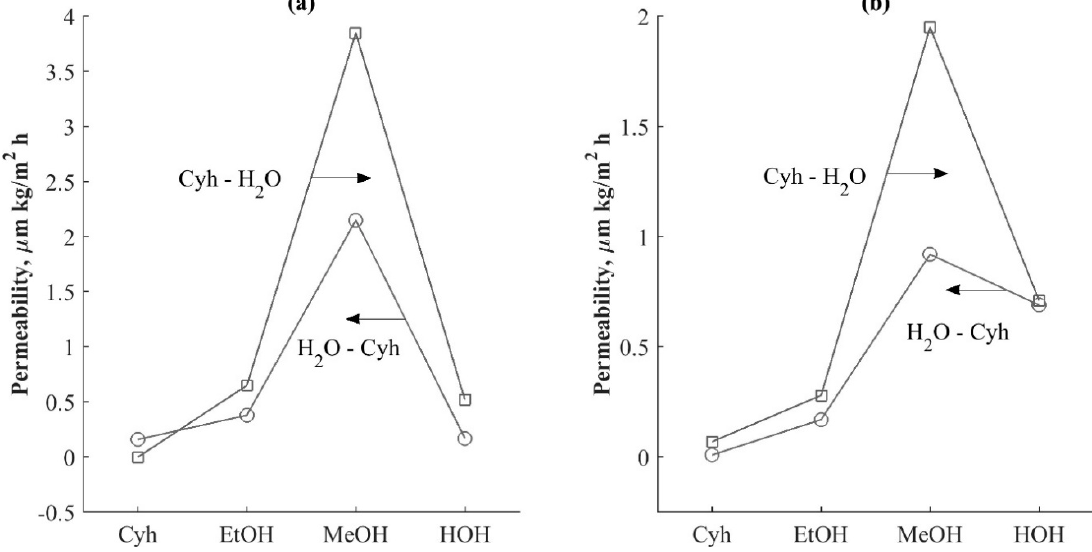
Figure 30. Pervaporation properties of ( a ) PAI-1 and ( b ) PAI-1-SNF films (Cyh—cyclohexane, EtOH—ethanol, MeOH—methanol, HOH—water). The sequence of penetrants during the pervaporation is as follows: direction 1: Cyh → EtOH → MeOH → HOH; direction 2: HOH → MeOH → EtOH → Cyh [150].